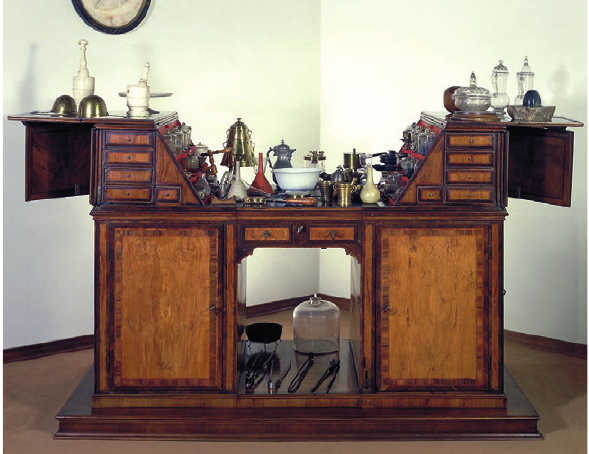
Figure 1. Leopold’s chemistry cabinet. Museo Galileo, Room